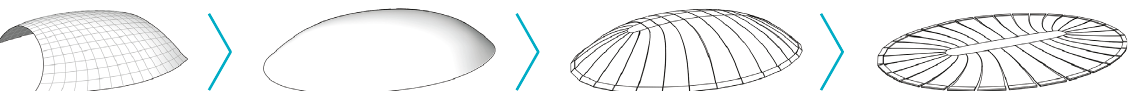
Figure 5: Methodology of the optimization process, starting with the optimization of the shape of the final bridge and ending with the initial flat concrete plate required for PFHC.